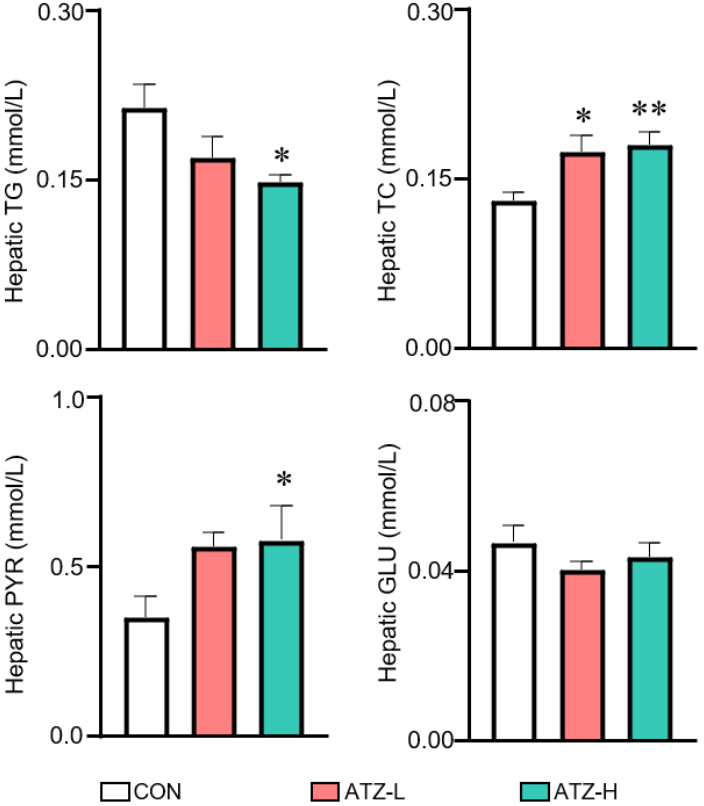
Figure 1. Changes in the levels of TG, TC, PYR and GLU in the liver of zebrafish treated with different concentrations of ATZ for 21 days. ATZ − L and ATZ − H represent 300 and 1000 µ g/L ATZ, respectively. The presented values are the means ± SEMs ( n = 6). Significant differences between the control and ATZ − treated groups were indicated with an asterisk (* p < 0.05, ** p < 0.01).